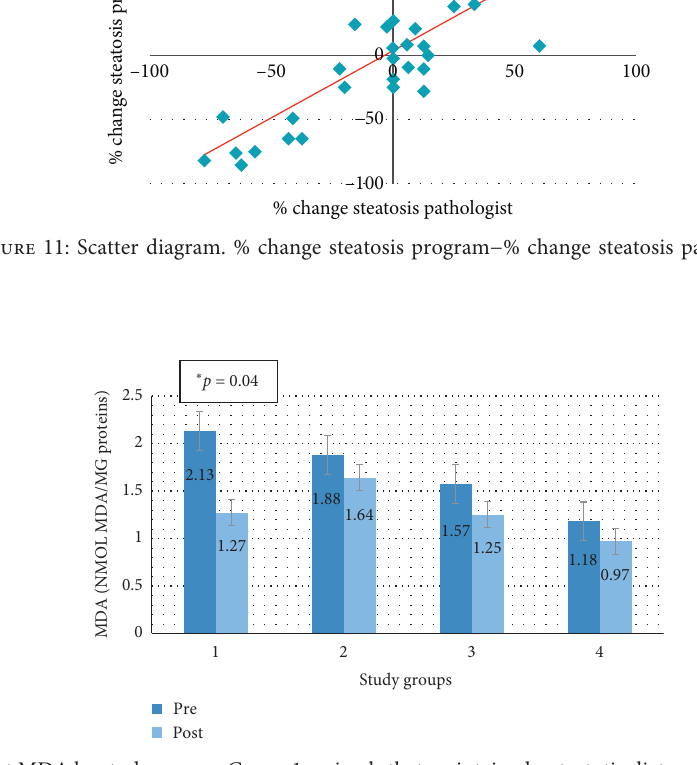
Figure 12: Average pre-post MDA by study groups. Group 1: animals that maintained a steatotic diet and received concomitant treatment. Group 2: animals that maintained a steatotic diet and received no drug. Group 3: animals that did not continue with the steatotic diet but received melatonin treatment. Group 4: animals that did not continue with the steatotic diet and did not receive any drug.